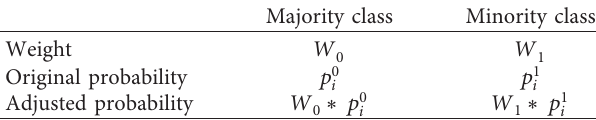
Table 2: The rule of utilizing weights to adjust prediction